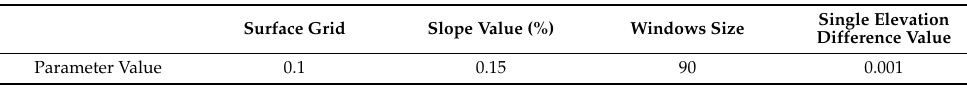
Table 5. Parameter setting for